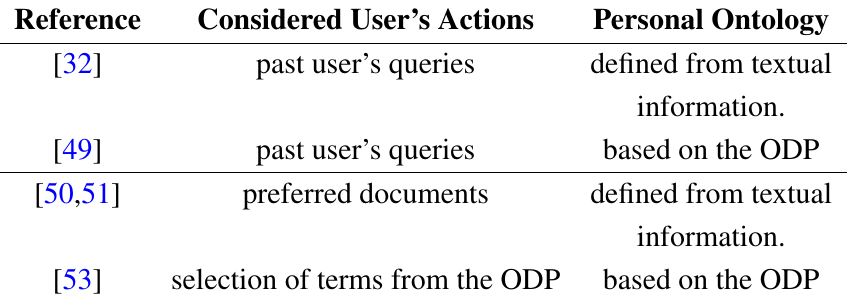
Table 1. Synthesis of the discussed methods for query